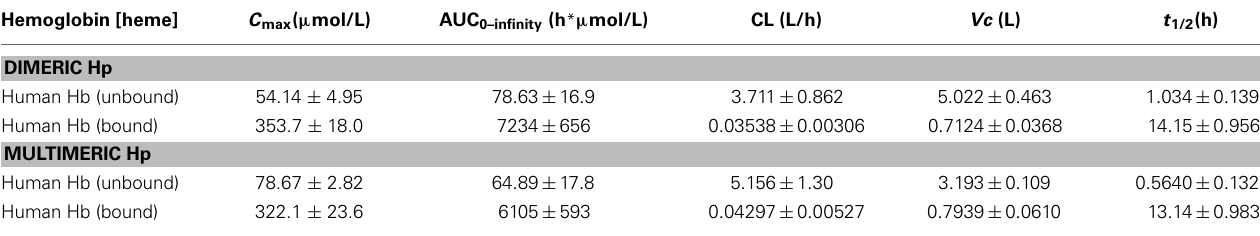
Table 3 | Pharmacokinetic parameters of Hb bound to dimeric and multimeric Hp (mean ± SEM) in Beagles. Hemoglobin